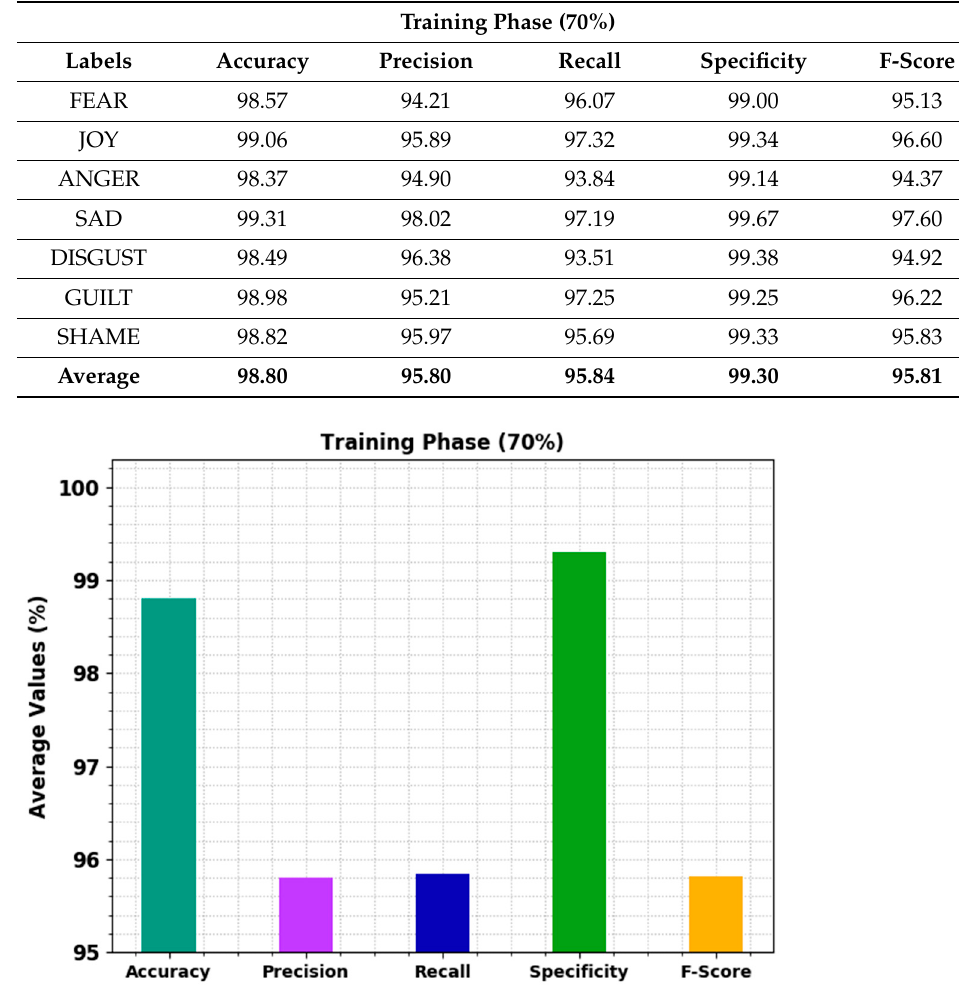
Table 3. Result analysis of CLBEDC-SND approach with distinct class labels under 70% of TR data.